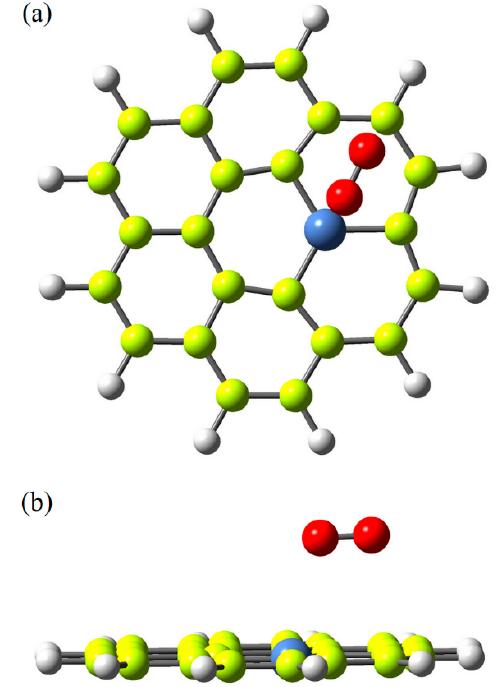
Figure 5. Side ( a ) and top ( b ) views of oxygen molecule adsorbed on Ni-doped graphene flake.